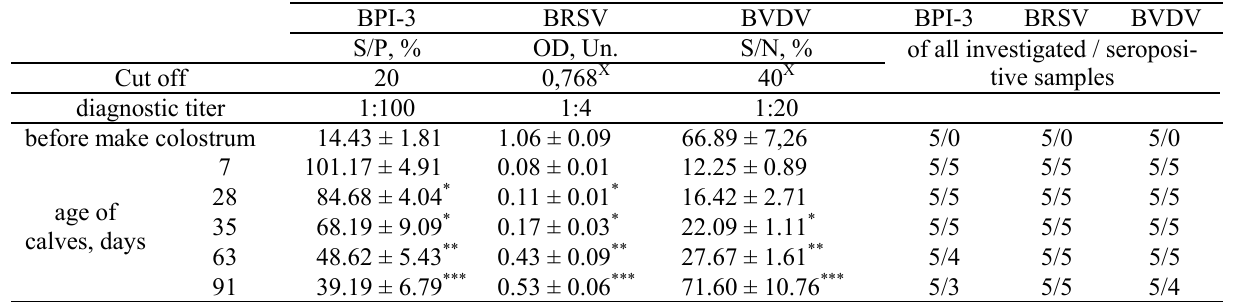
Table 1 The level of antigen-specific IgG to the pathogens BPI-3, BRSV, BVDV in serum calves (M ± m, n = 5) BPI-3 BRSV S/P, % OD, Un. diagnostic titer 1:100 before make colostrum